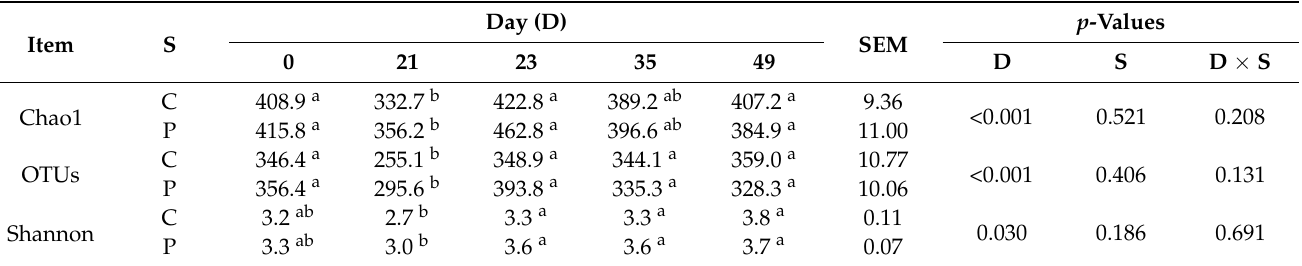
Table 6. Means of alpha diversity indexes of dogs fed a lower protein and fiber diet (day 21) transitioned to a higher protein and fiber diet (days 23 to 49) without (C) or with (P) yeast supple- mentation